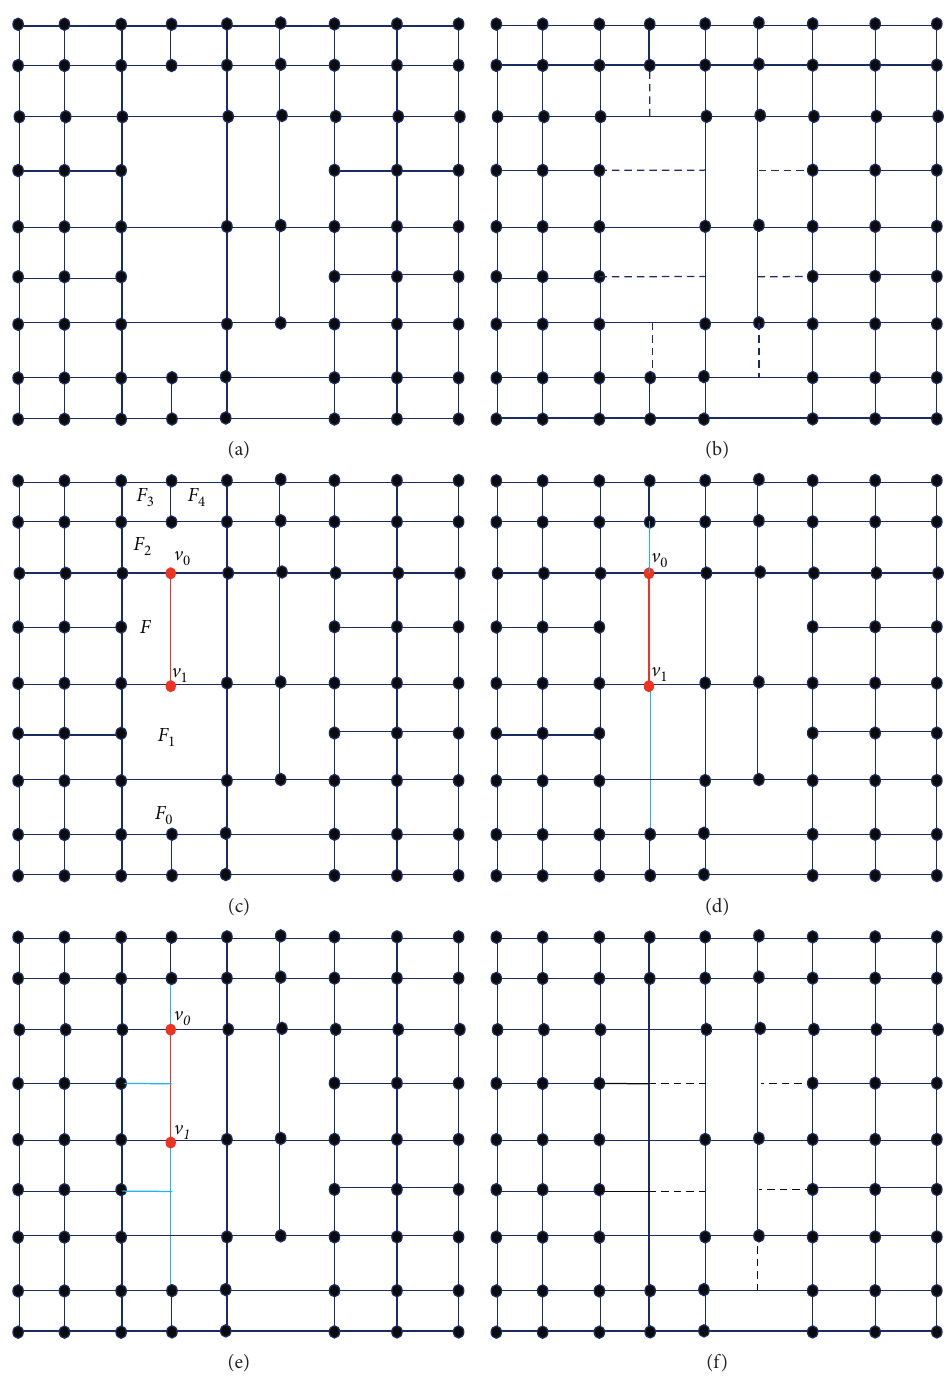
Figure 10: Steps of local refinement algorithm. (a) Design-suitable T-mesh T 1 , (b) extended T-mesh T 1 first step: extend v and v , (e) design-suitable T-mesh T 2 , (f) extended T-mesh T 2 e 0 1